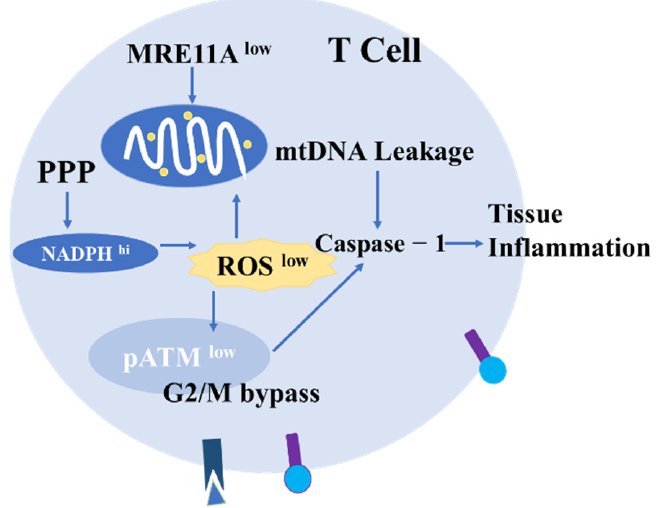
Figure 6. The role of ROS in T cells. In T cells, inadequate activation of the DNA repair kinase ATM bypasses the G2/M cell cycle checkpoint due to intracellular ROS consumption. In addition, MRE11A inhibition leads to reduced mitochondrial ATP and ROS production, mtDNA deposition, caspase-1 activation and invasive tissue inflammation.